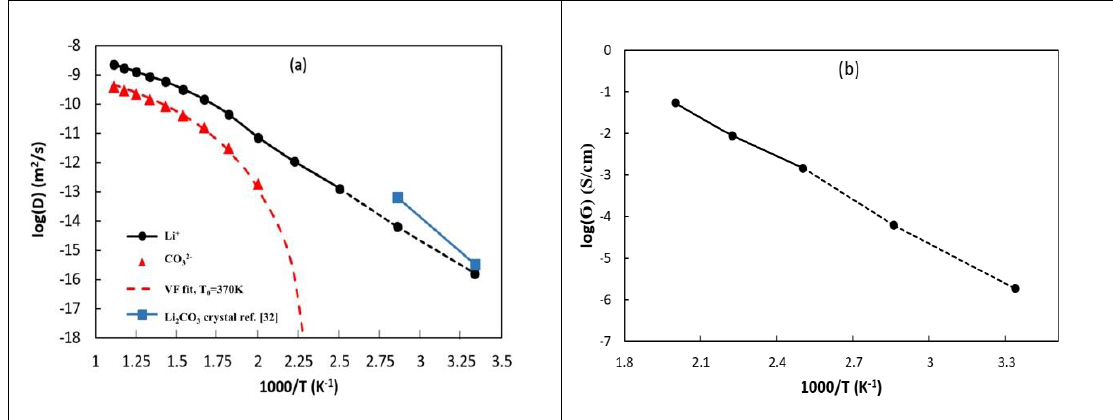
Figure 6. ( a ) Diffusion coefficients of anion and cation and ( b ) ionic conductivity of Li. in Li 2 CO 3 as a function of inverse temperature as obtained from MD simulations. Also shown are the data from atomistic MD simulations of crystalline Li 2 CO 3 from ref. [32].